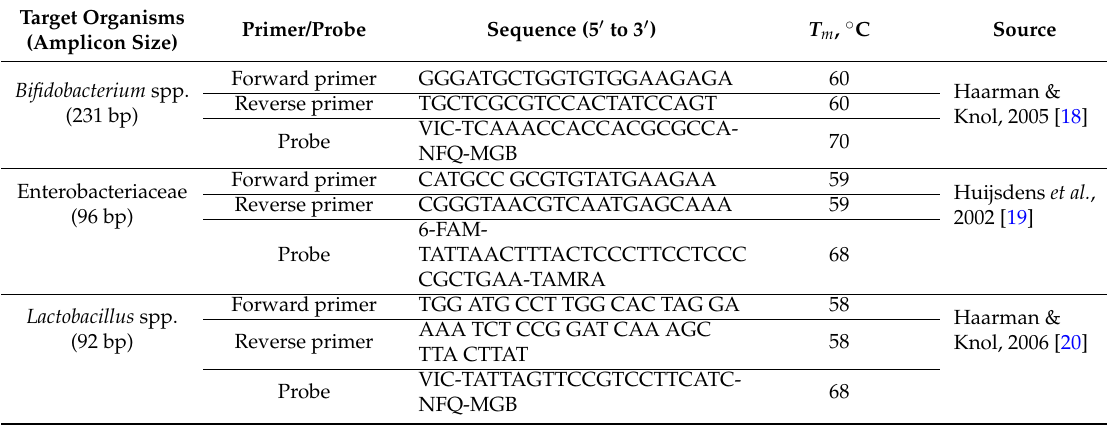
Table 1. Primers and probes used in this